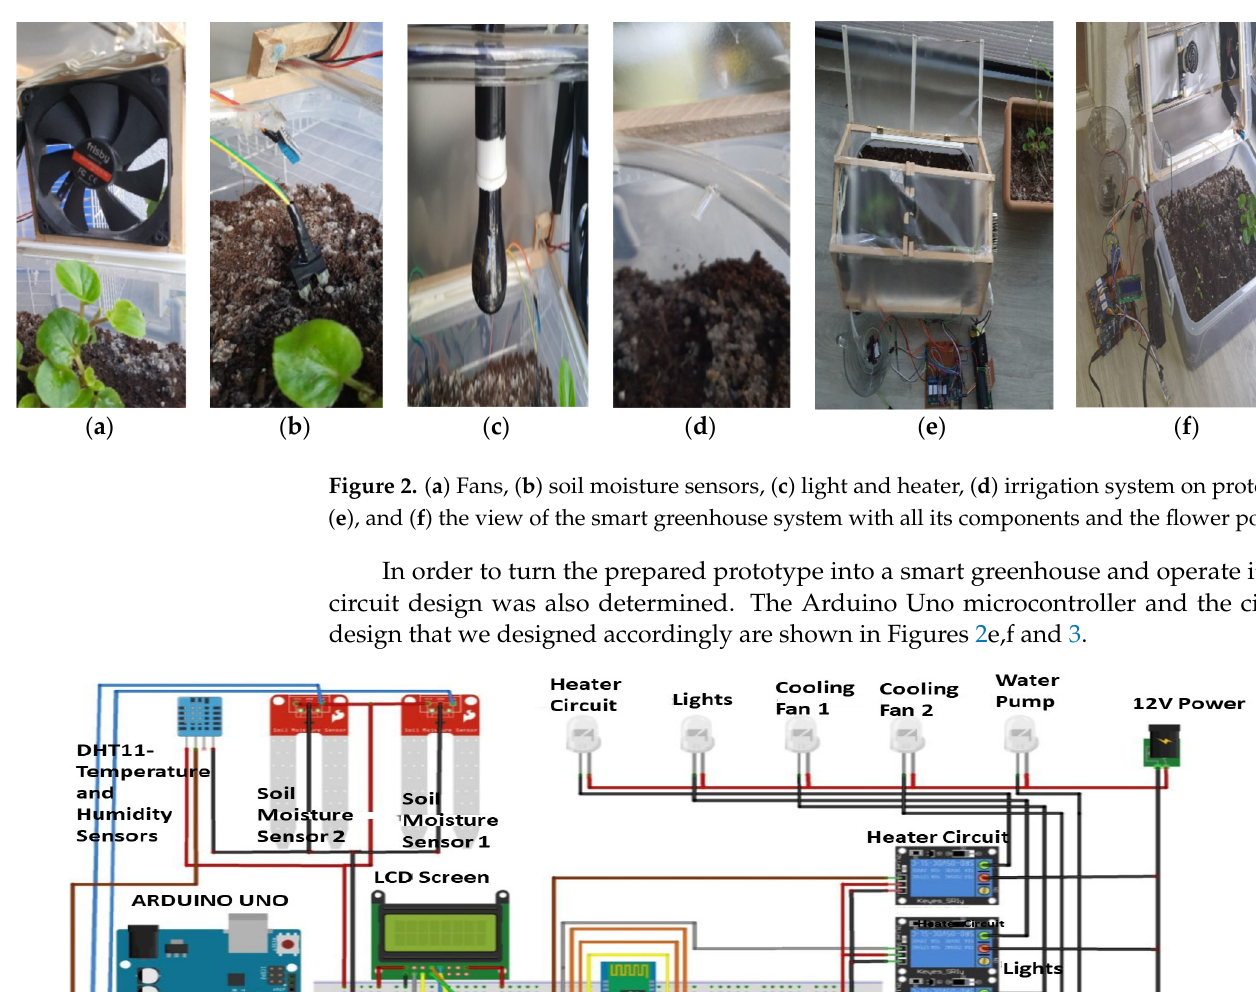
Figure 1. Planting order of begonia and three of the vegetables in the greenhouse and the pot.